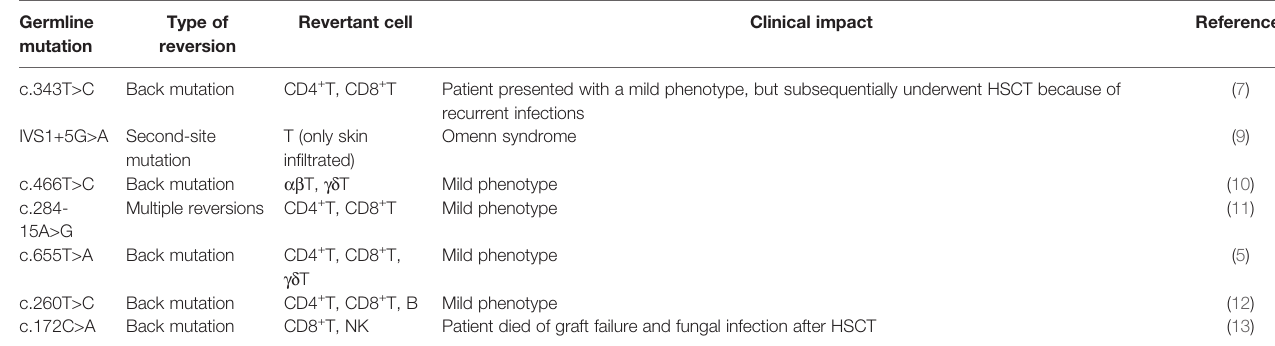
TABLE 2 | Clinical and genetic features of revertant cases of